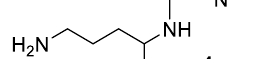
Figure 2. Key metabolite ( 4 ) of 8-aminoquinolines 2 and 3 .